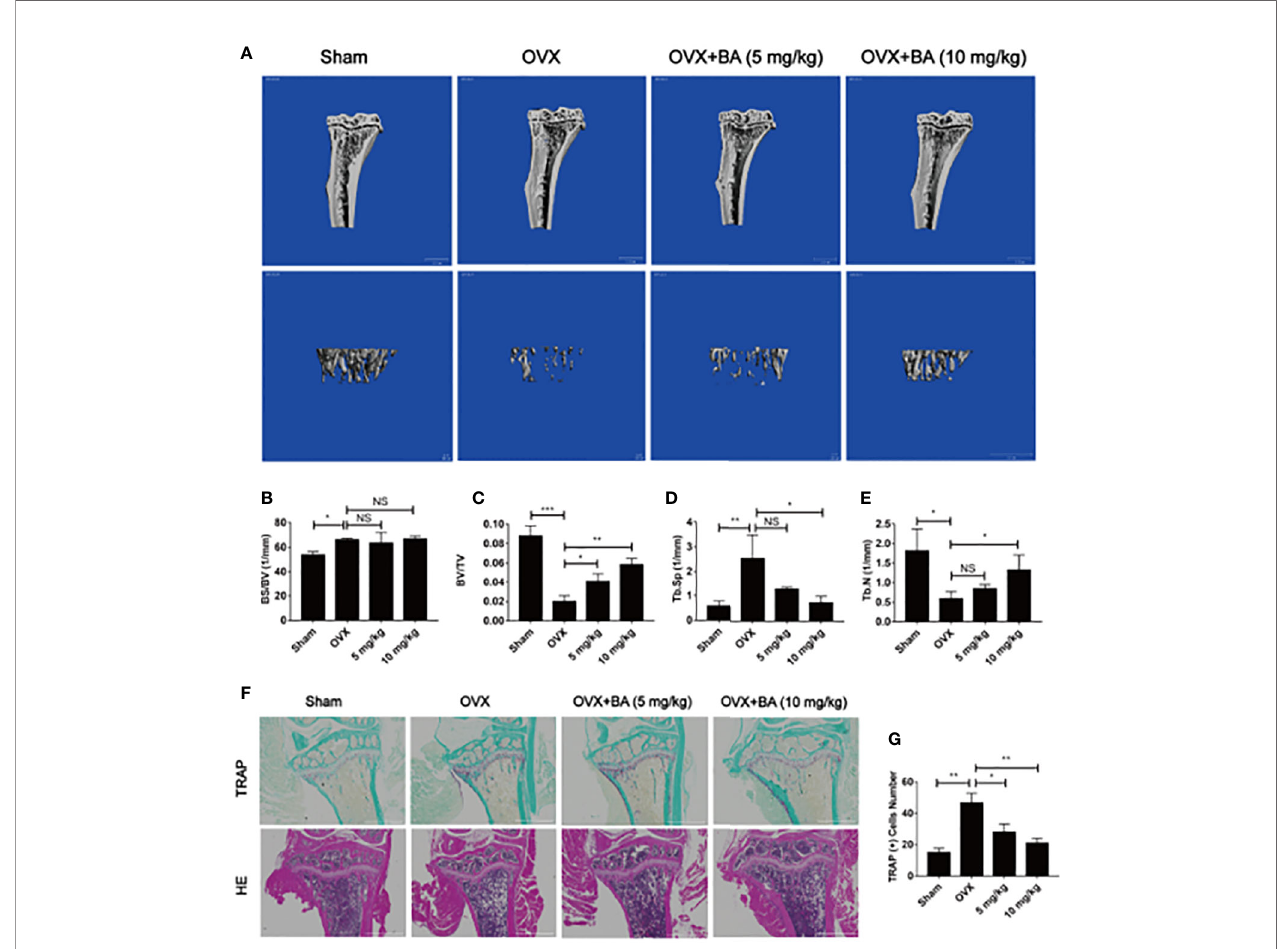
FIGURE 5 | BA prevents bone loss in mice with ovariectomized (OVX)-induced osteoporosis. (A) Representative 3D reconstruction micro-CT images of tibial micro- architecture. (B – E) Quantitative micro-CT assessment of trabecular bone volume fraction (BV/TV), bone surface area/total volume (BS/TV), speci fi c bone surface (BS/BV) and trabecular number (Tb.N). (F) Representative photographs of tibia samples after TRAP and H&E staining. (G) Quantitation of TRAP ‐ positive cells (n = 3). Data are mean ± SD. *p <0.05, **p <0.01, ***p <0.001 vs. OVX group. BA, Betulinic acid; OVX,